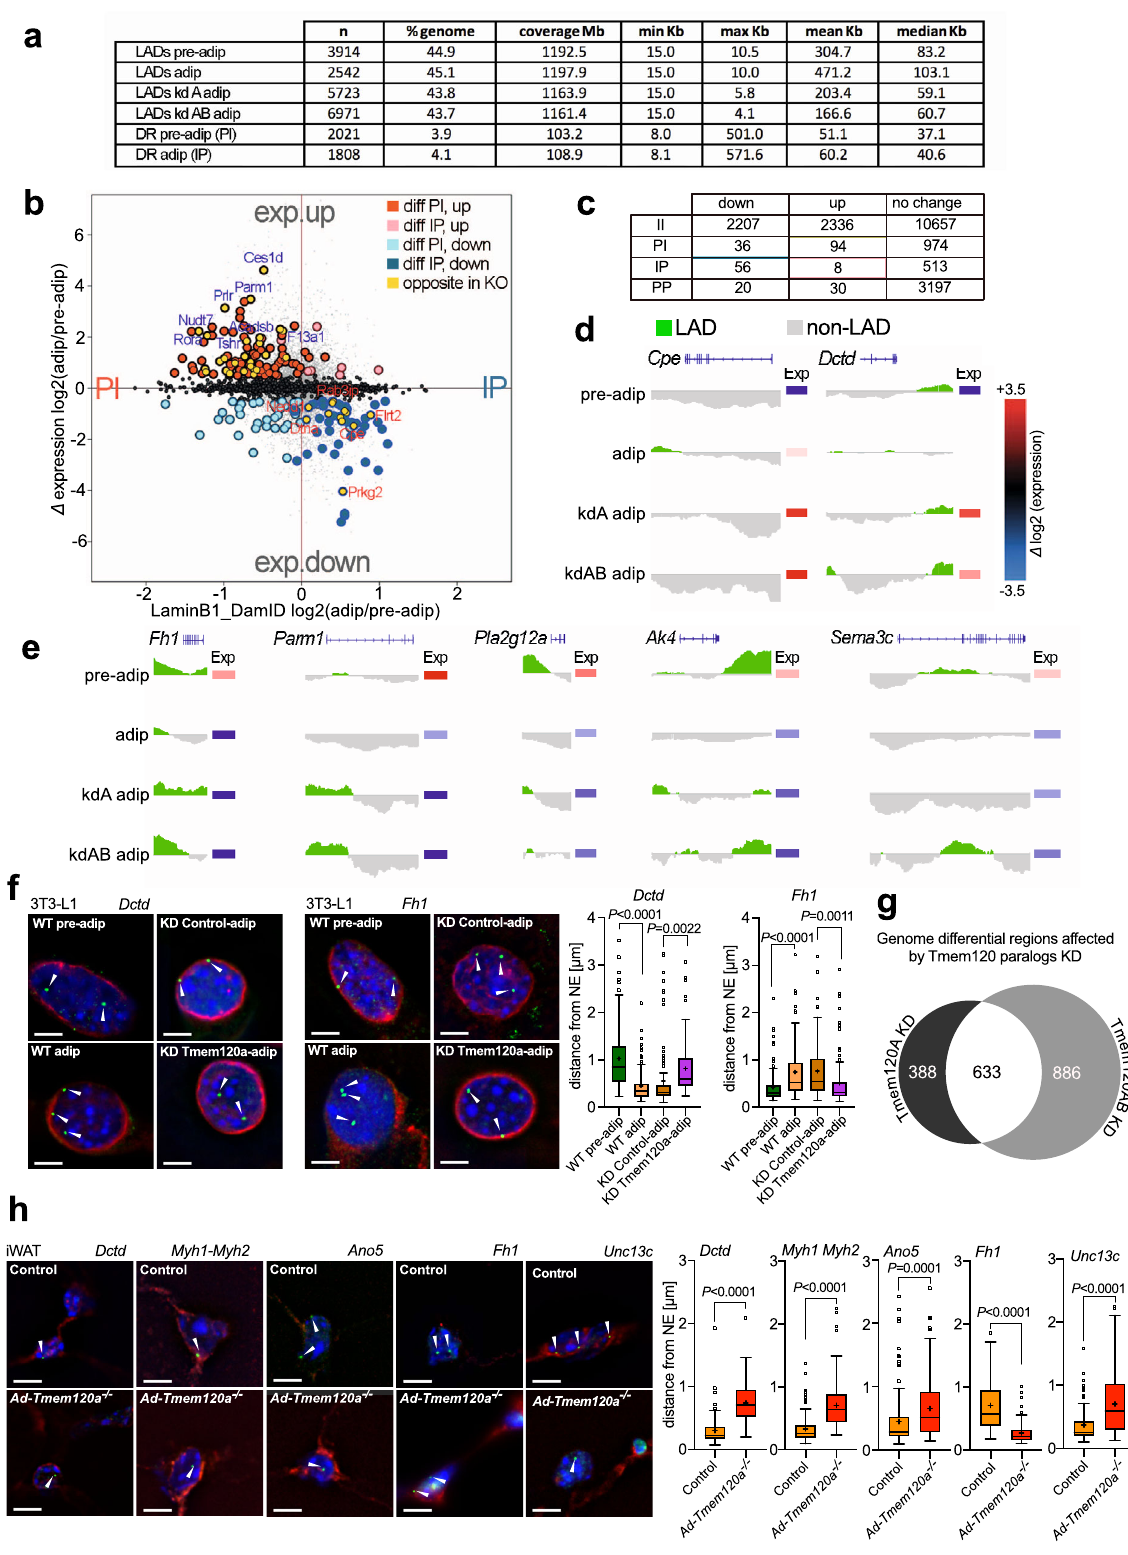
577 genes recruited to newly formed LADs, 56 reduced expression (Fig. 5b, c; Supplementary Data 3). A subset of these were under Tmem120A positional regulation (highlighted in yellow), but they tended to be relevant to fat metabolism and lipodystrophy associated comorbidities. For example, genes at DRs normally moving to the NE to become repressed that